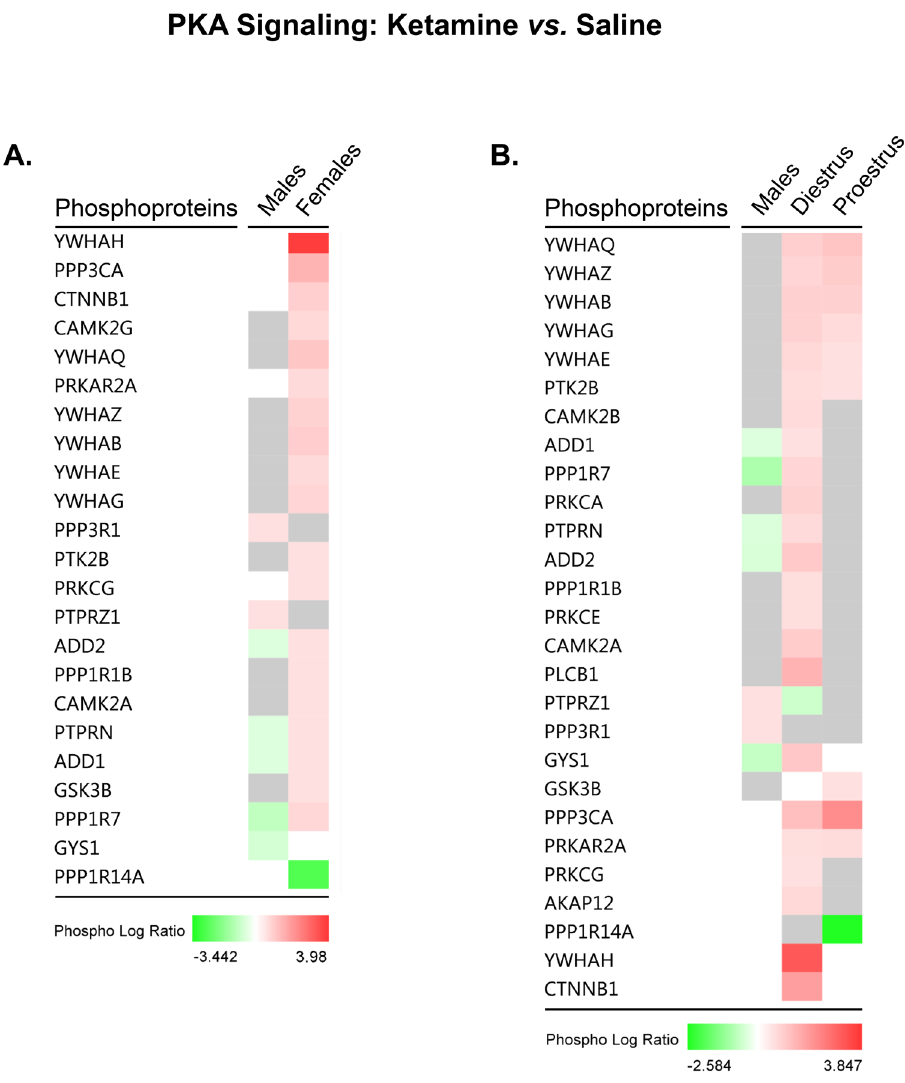
( B ) of dHPC phosphoproteins whose abundance was significantly altered by 2.5 mg/kg ketamine in intact male and female rats. Heat maps were generated using Ingenuity Pathway Analysis (IPA) software (QIAGEN,